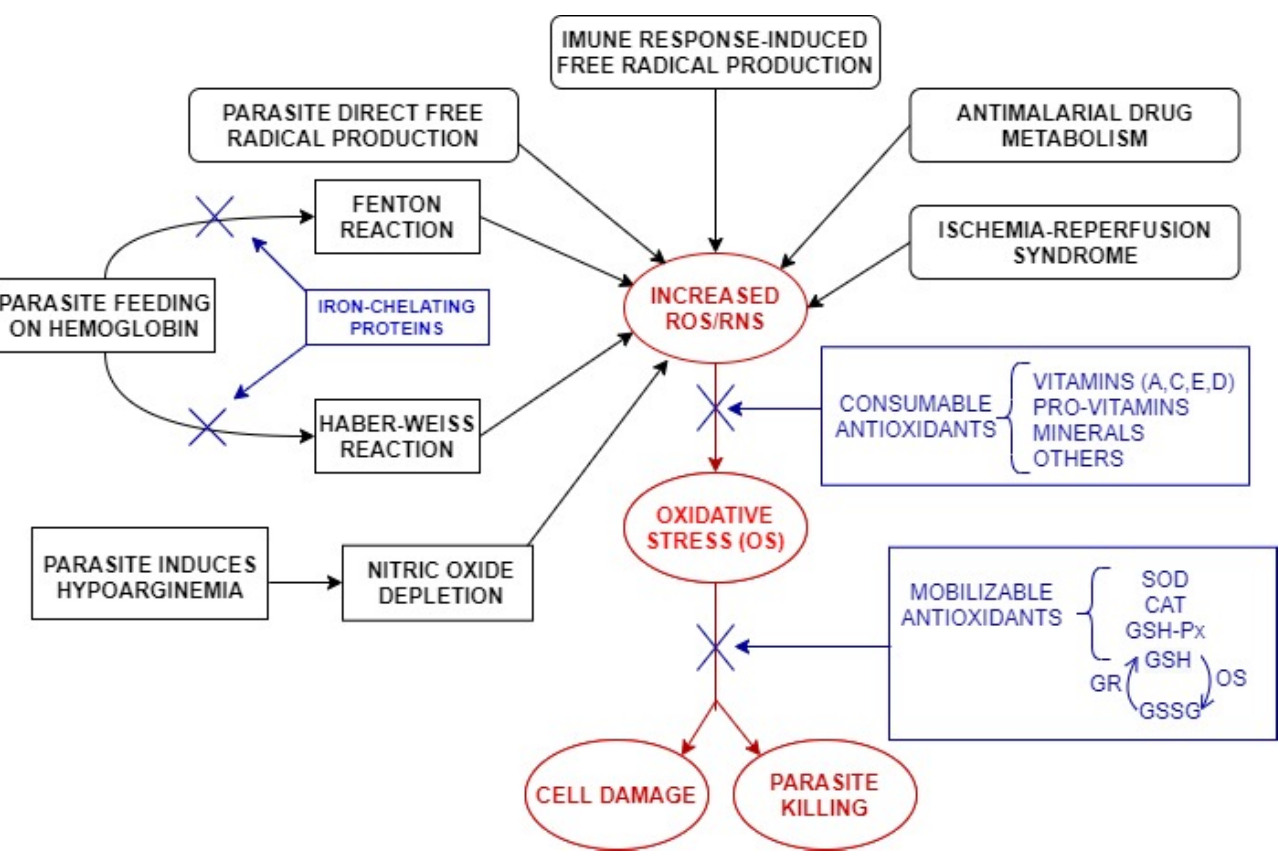
Figure 2. Antioxidant defense (blue) and mechanisms of free radical involvement (black) in malaria. ROS = reactive oxygen species; RNS = reactive nitrogen species; SOD = superoxide dismutase; CAT = catalase; GSH-Px = glutathione peroxidase; GSH = reduced form of glutathione; GR = glutathione reductase; GSSG = oxidized form of glutathione.